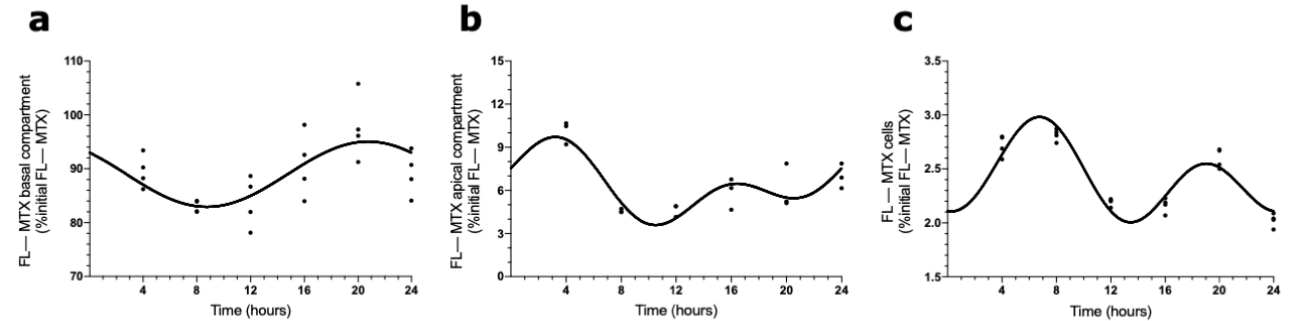
Figure 4. FL–MTX transport across the BCSFB. CircWave analysis of FL–MTX levels from basal ( a ), apical ( b ), and intracellular ( c ) compartments. The represented curves indicate a statistically significant rhythm (CircWave, p < 0.05).